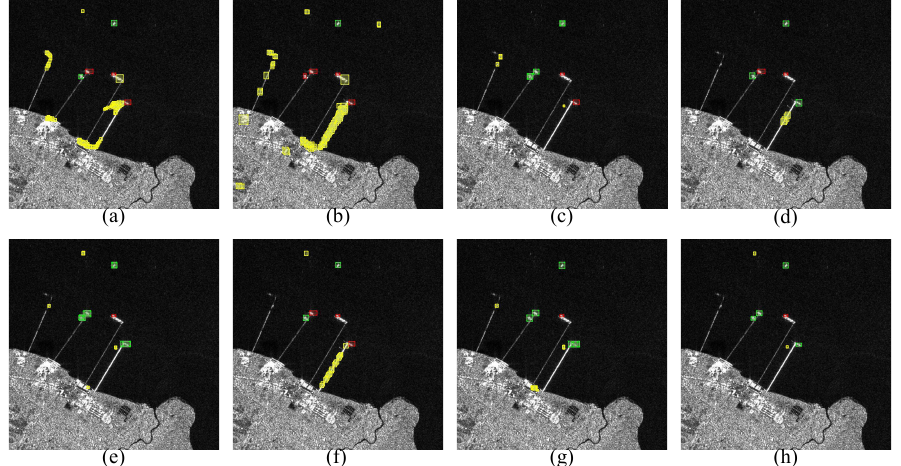
Figure 12. Visualization of detection results with different detectors in scene 3. ( a ) RetinaNet. ( b ) ATSS. ( c ) YOLOv5. ( d ) Faster R-CNN. ( e ) Double-head R-CNN. ( f ) Cascade R-CNN. ( g ) Dynamic R-CNN. ( h ) The proposed method.